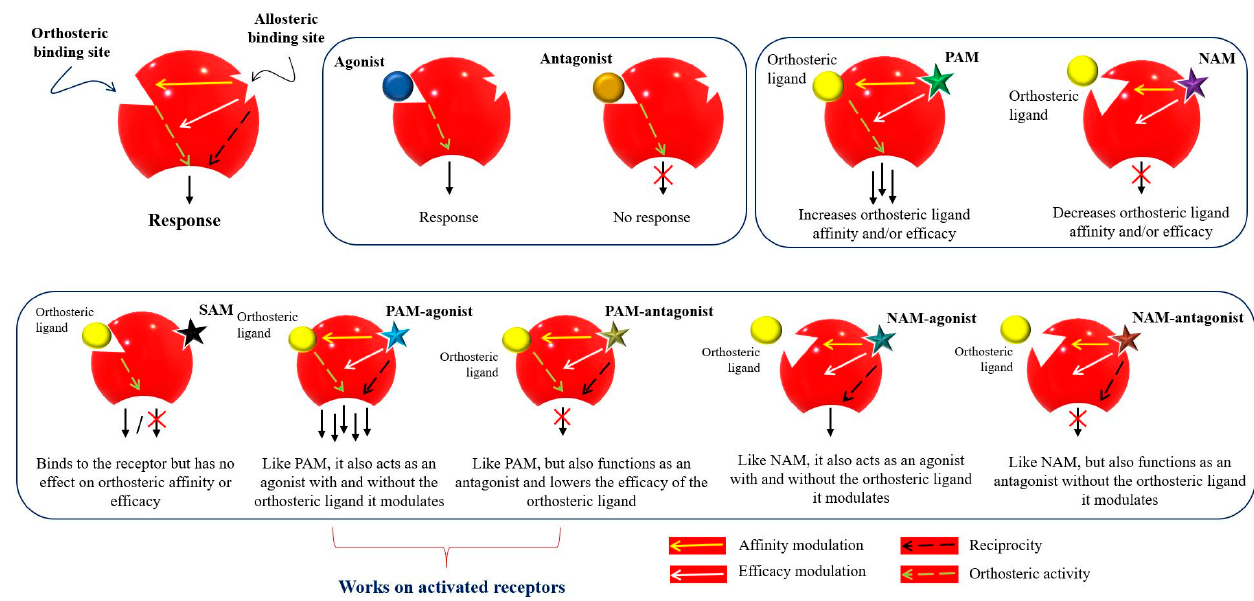
Figure 3. Mode of action and classification of allosteric modulators. Graphical representation of orthosteric and allosteric sites of a receptor. Allosteric ligands bind to a topographically distinct site on a receptor to modulate orthosteric ligand affinity (yellow arrow) and/or efficacy (white arrow). Some allosteric ligands can directly activate their signaling (black arrow). Orthosteric ligands (agonist or antagonist) are colored yellow. Star-shaped allosteric modulators are presented with different colors. PAM—positive allosteric modulator; NAM—negative allosteric modulator; SAM—silent allosteric modulator [53,57,63,64].